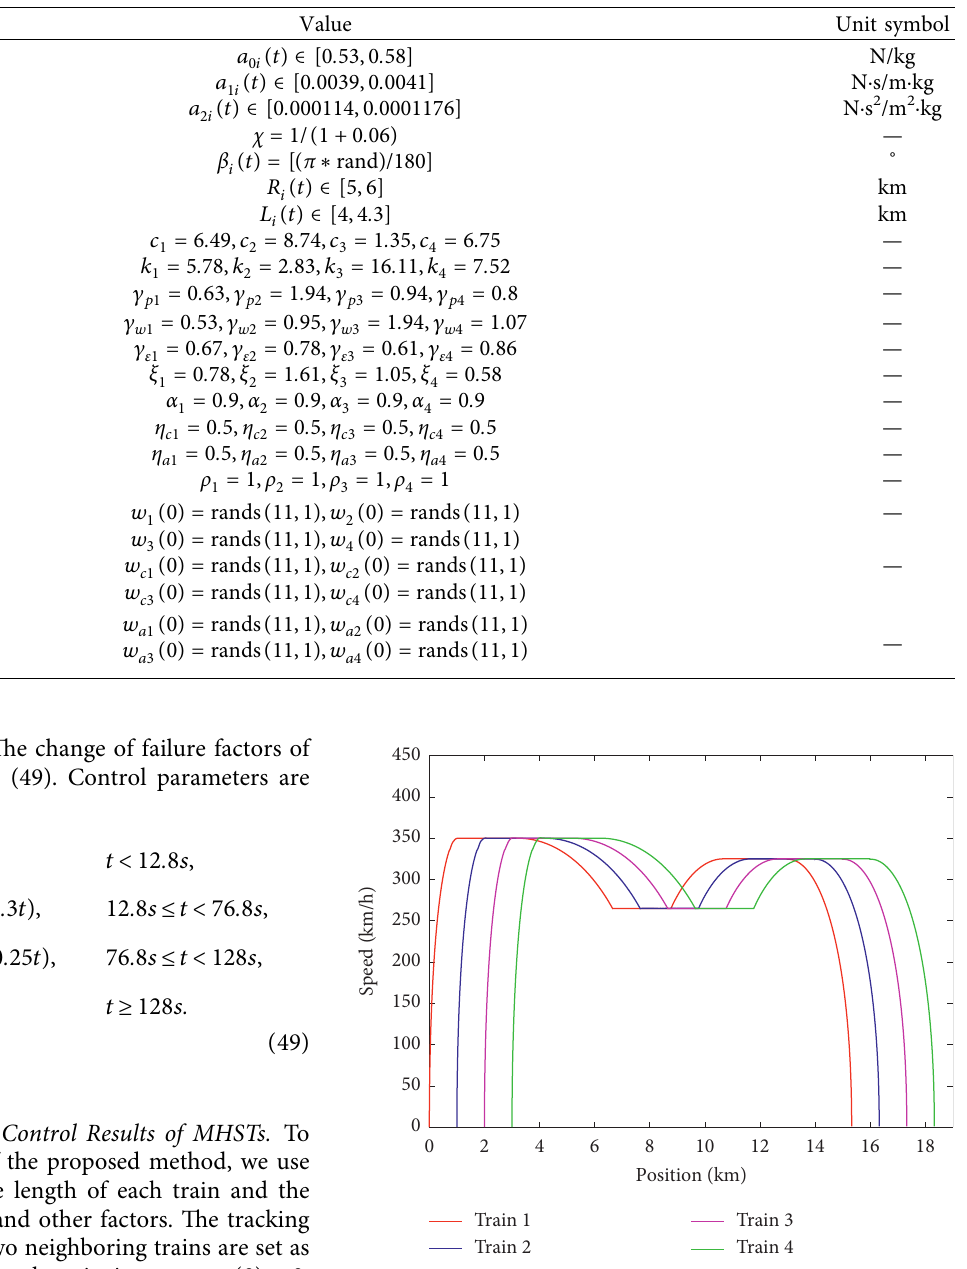
Figure 3: The speed and position tracking results of MHSTs using the proposed